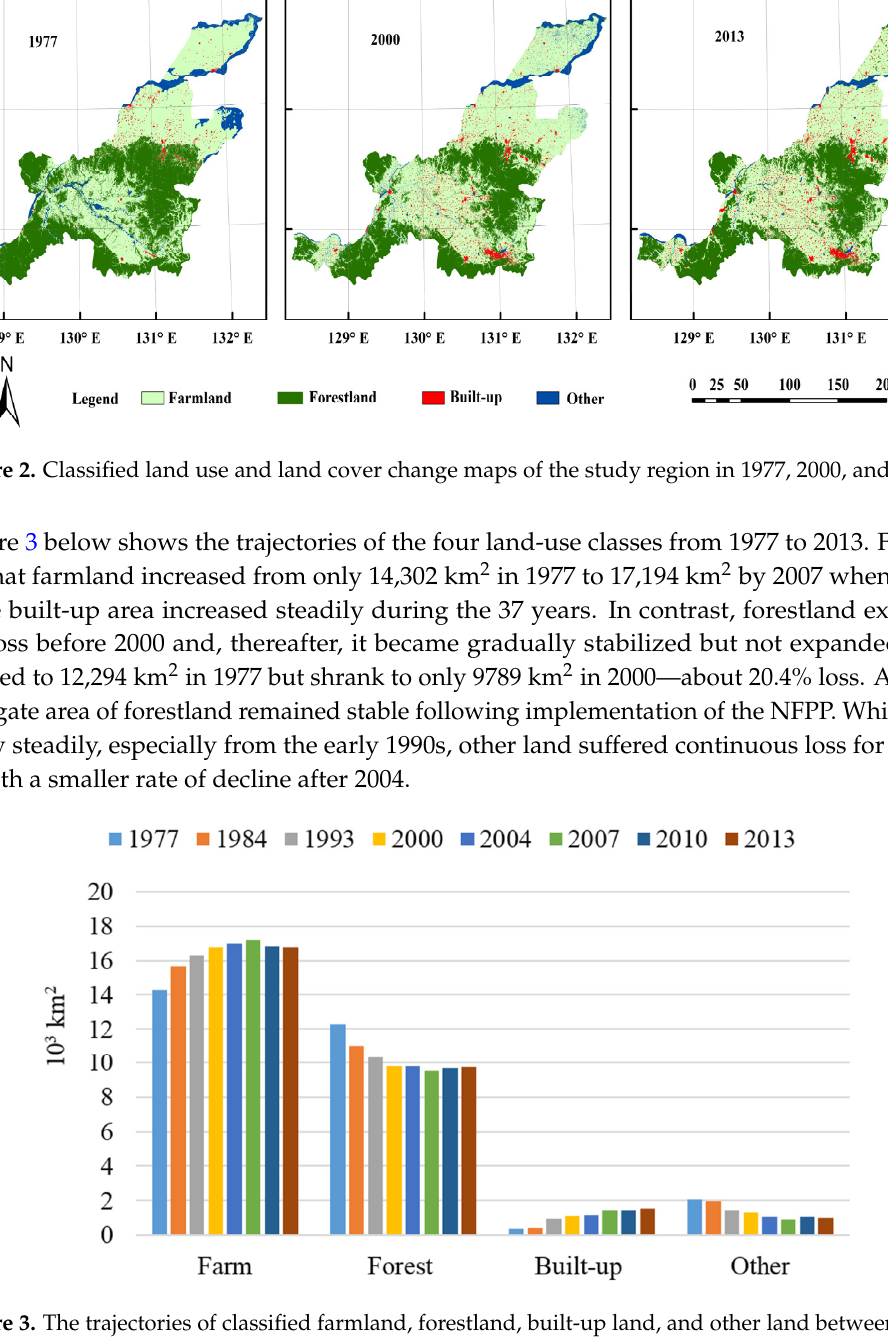
Figure 3. The trajectories of classified farmland, forestland, built-up land, and other land between 1977 and 2013.